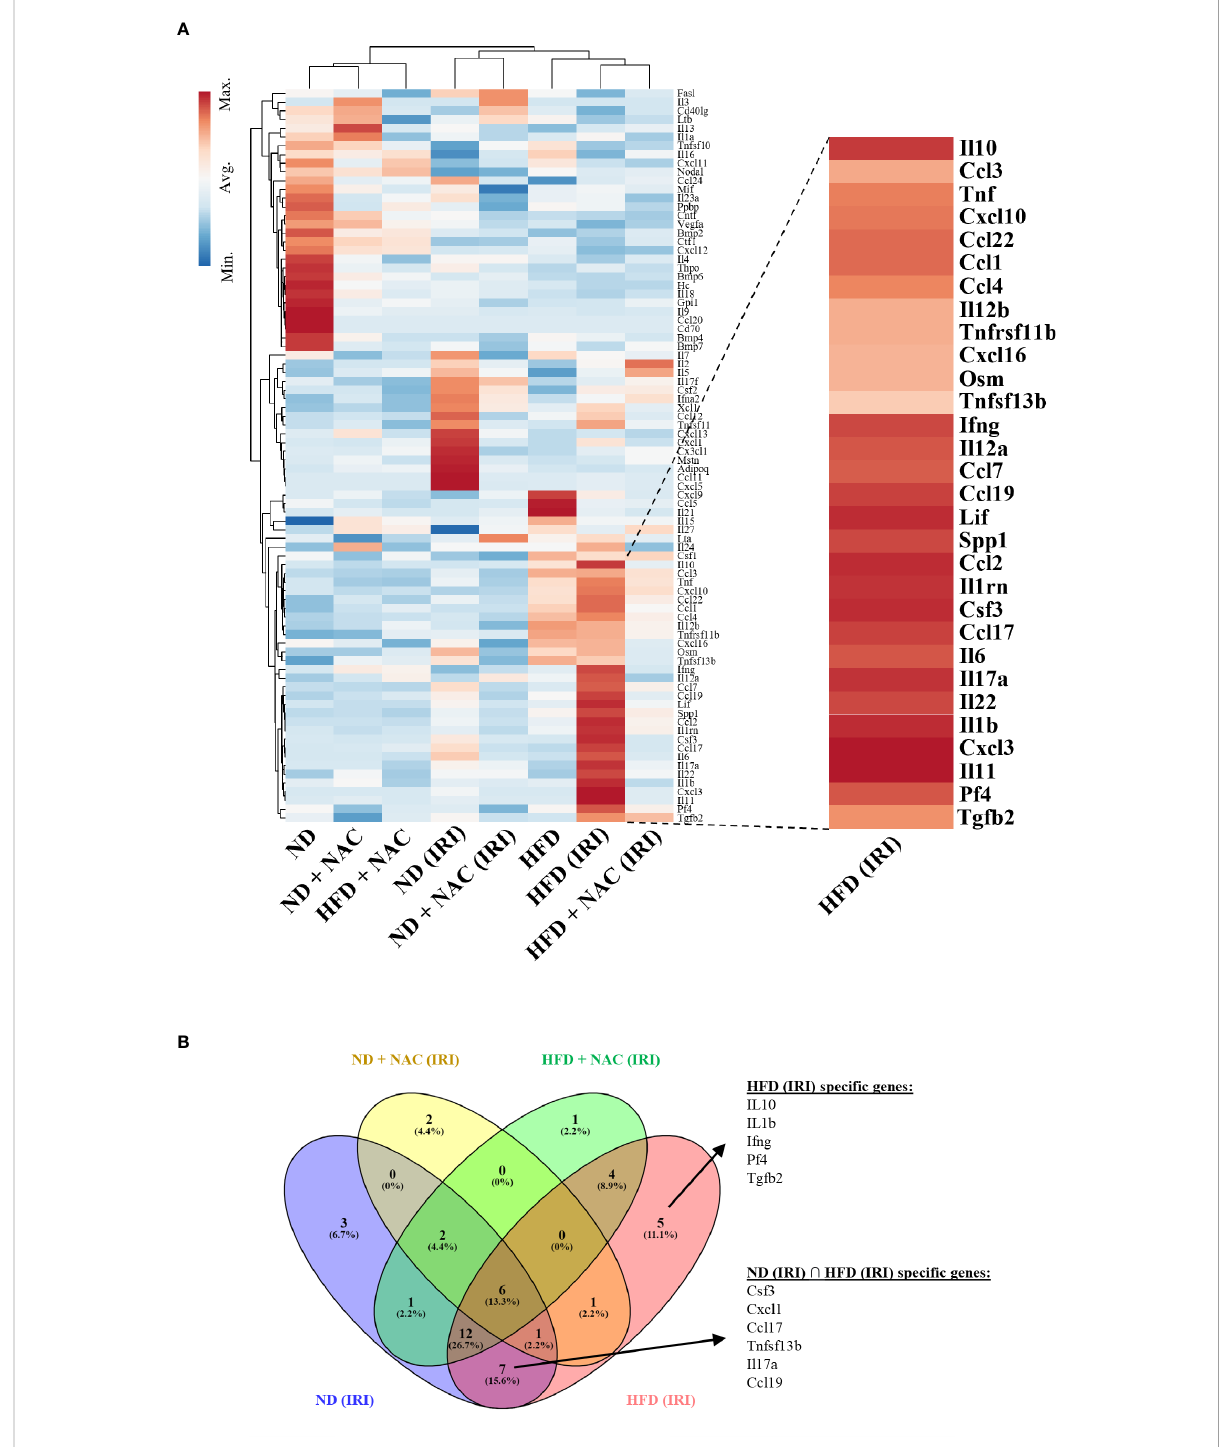
FIGURE 6 IRI induced speci fi c genetic upregulation in HFD mice. RT 2 pro fi ler PCR array for cytokines and chemokines was utilized to examine differences in genetic regulation among treatment groups. Each group represents a single pooled sample from at least three separate liver-tissue specimens. (A) Heat map of cytokine and chemokine PCR analysis. (B) Venn Diagram demonstrating genes that are upregulated in HFD (IRI) and those shared amongst ND (IRI) and HFD